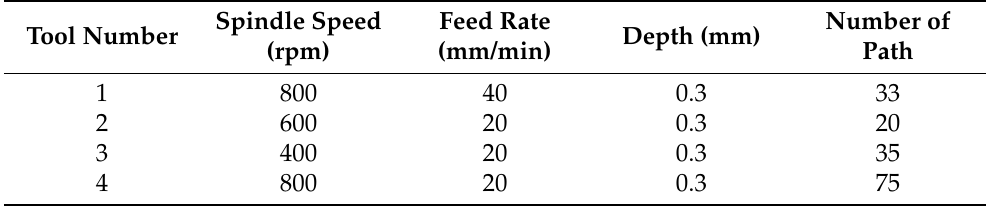
Table 1. Experimental Cutting Parameters.